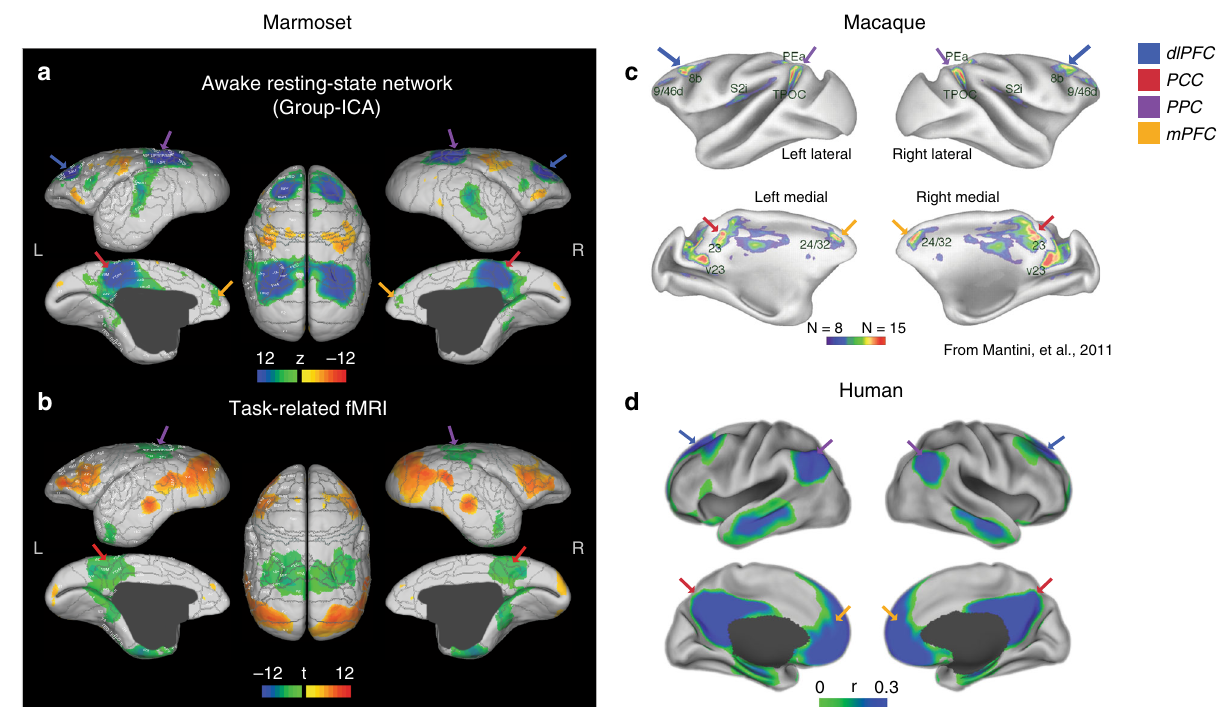
Fig. 2 The marmoset DMN and cross-species comparison. a The group-ICA DMN component of marmosets under the default (low) threshold is shown on a brain surface map. The color map is reversed (i.e., the cold colors represent the DMN regions). Areal borders are the Paxinos parcellation from the NIH Marmoset Brain Atlas 11,15 . b Regions that activate (warm colors) and deactivate (cold colors) during the visual task (Fig. 1d) in two marmosets. c DMN in macaques adapted from Mantini et al. 6 , where regions that deactivate in at least 8 out of 15 different tasks are shown. The color bar shows the number of tasks during which a region deactivates. d Typical human DMN generated by the Neurosynth metanalysis 13 , which shows the functional connectivity to the posterior cingulate cortex (seeding at the coordinate (0, − 44, 28)). Note that atlas labels of marmosets and macaques are de fi ned by different anatomical atlases, which do not have one-to-one homologous relationships across species. dlPFC dorsal – lateral prefrontal cortex, PPC posterior parietal cortex, PCC posterior cingulate and medial parietal cortex, mPFC medial prefrontal cortex. Arrows identify the different regions according to the color legend